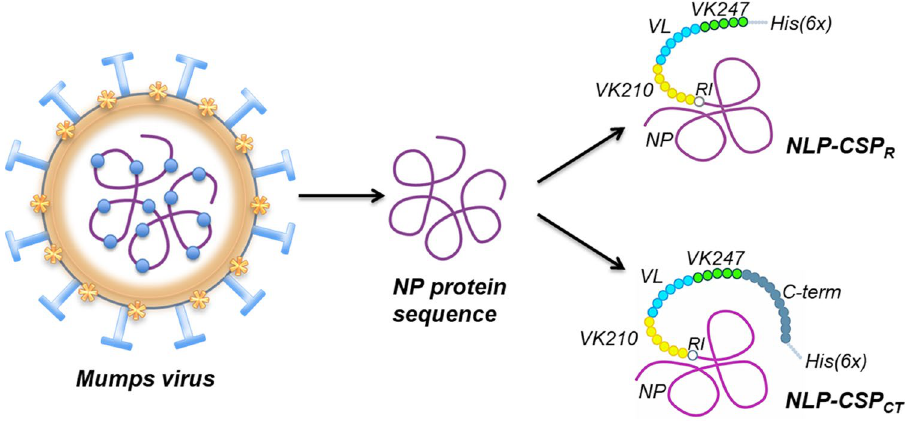
Figure 1. Schematic representation of mumps virus and NLP-CSP proteins. Mumps virus proteins are represented in the left panel. From outside to inside: Hemagglutinin-Neuraminidase protein (light blue) and Fusion protein (gold) in the membrane surface; Matrix protein (orange) and Nucleocapsid protein (purple) with associated RNAs (blue) in the inside. NLP-CSPs proteins are represented in the right panels. NP sequence is represented in purple, Pv CSP-RI sequence in withe circle, Pv CSP-VK210 repeats in yellow circles, Pv CSP- P. vivax -like (VL) in cyan circles, Pv CSP-VK247 in green circles, Pv CSP-C-terminal sequence in dark grey and the His-tag sequence in light grey.